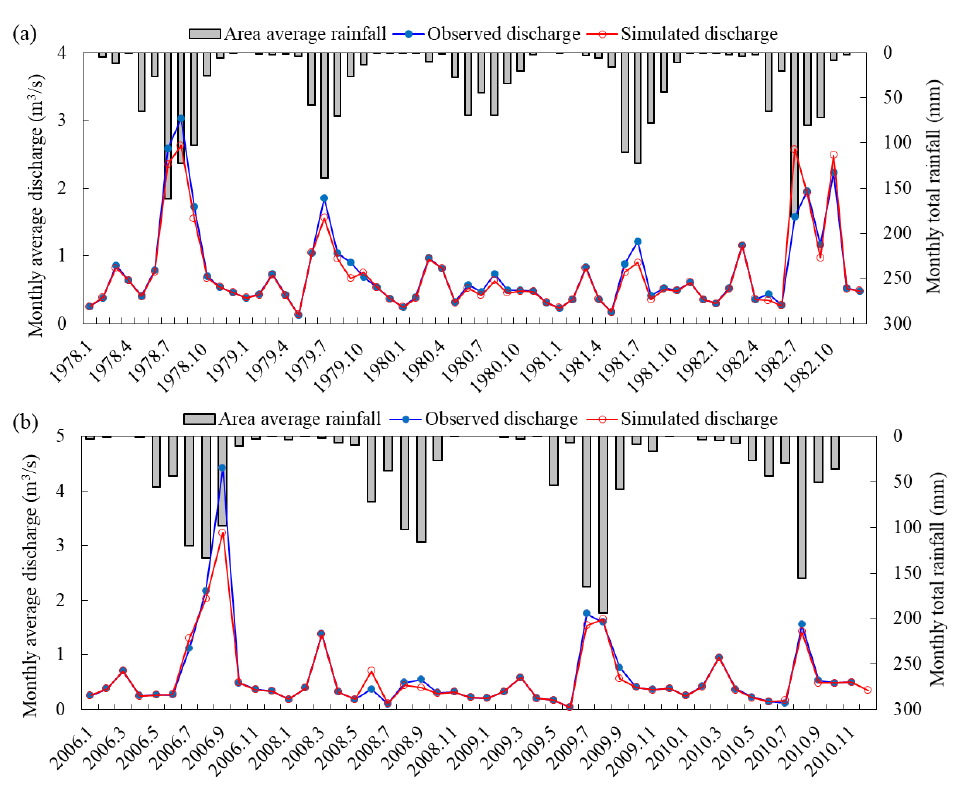
Figure 3. Comparison between observed and simulated monthly average discharges in the 1980s ( a ) and the 2010s ( b ).